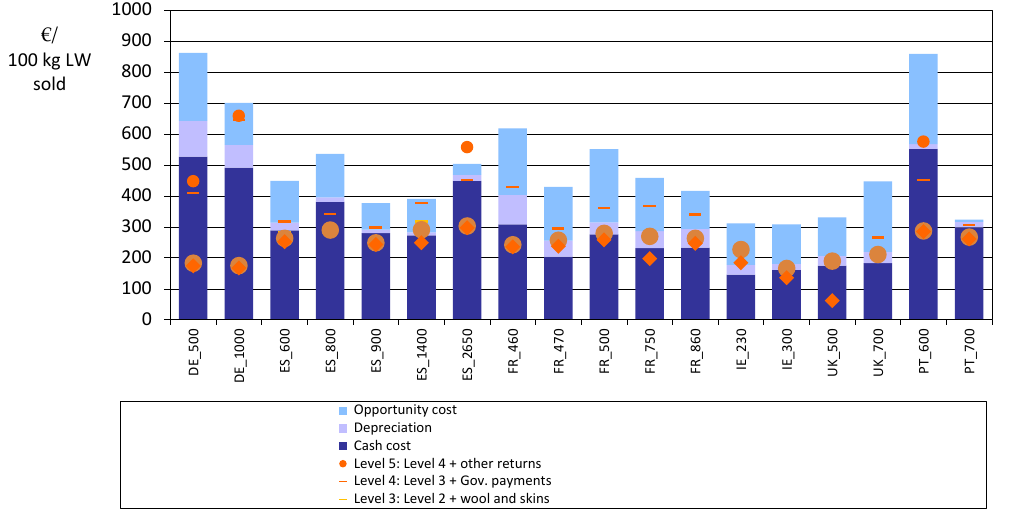
Figure 11. Cash and non-cash costs, returns and profitability ( € / 100 kg LW sold). Source: model results.